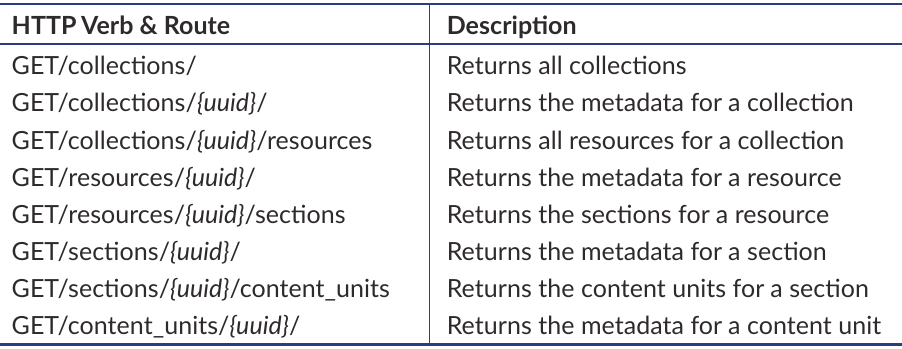
Table 1: The minimum set of API routes for a SHINE-compatible resource